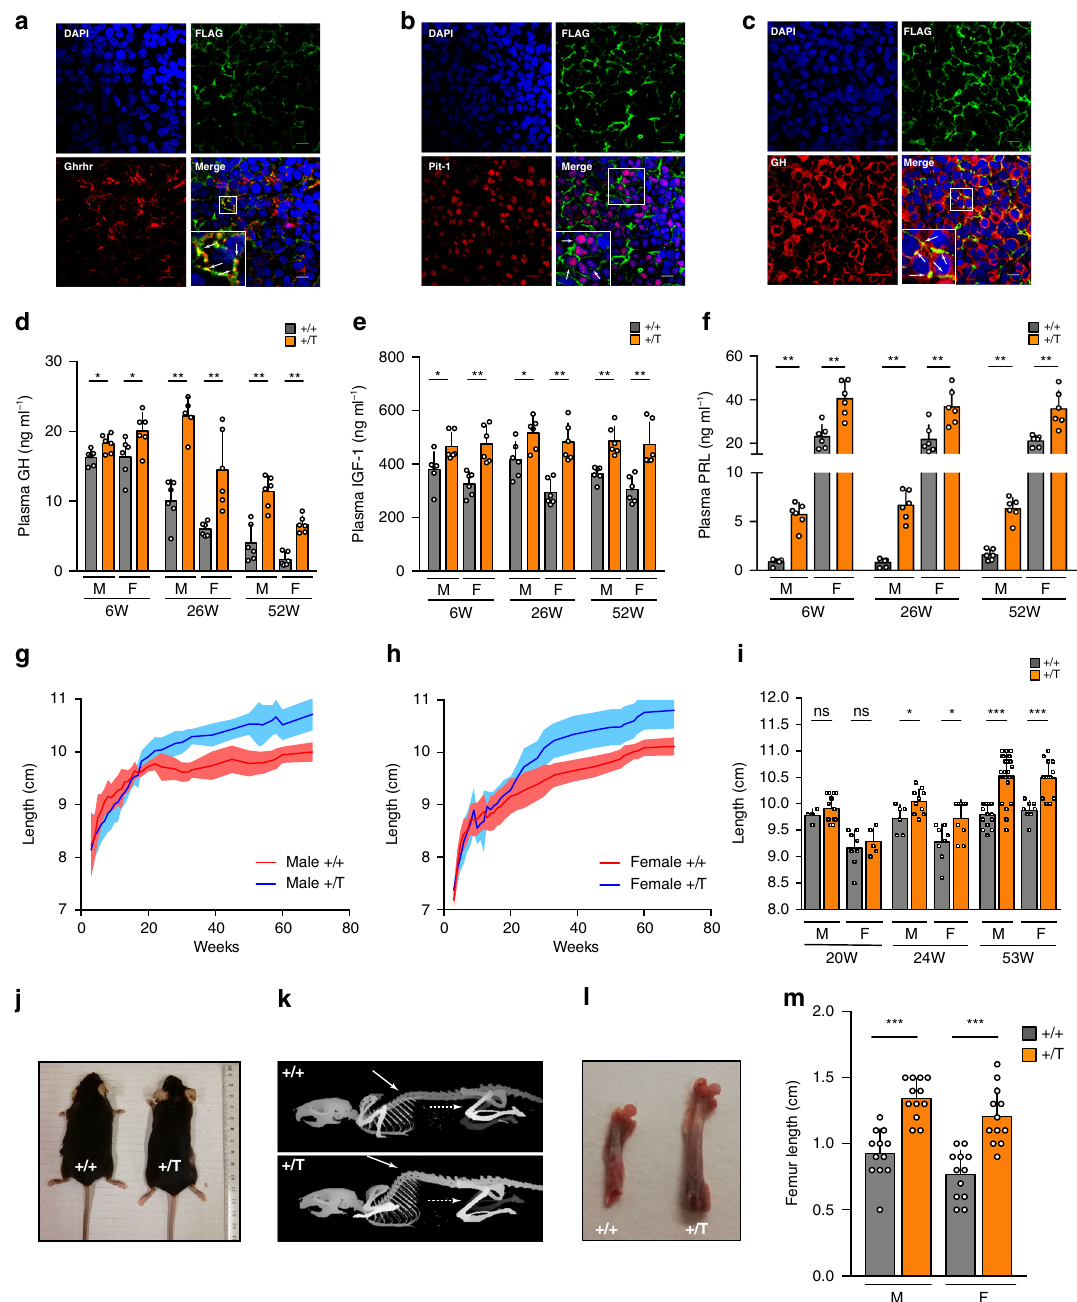
Fig. 1 Gpr101 promotes GH/IGF-1 and PRL hypersecretion and overgrowth in vivo. a – c Immuno fl uorescent staining of anterior pituitary from 29-week- old Ghrhr Gpr101 Tg mice. Blue: DAPI. Green: FLAG antibody. Red: a Ghrhr antibody, b Pit-1 antibody and c . GH antibody. (×60 magni fi cation, scale bar: 10 µ m). These experiments were repeated at least 3 times. d , e Determination in WT ( + / + ) and Ghrhr Gpr101 ( + /T) ( n = 6 mice per group) of plasma levels of d GH. Males 6 W: p = 0.0411, 26 W and 52 W: p = 0.0022. Females 6, 26, and 52 W: p = 0.0022. e IGF-1. Males 6 W and 26 W: p = 0.0260, 52 W: p = 0.0022. Females 6, 26, and 52 W: p = 0.0022. f PRL. Males 6, 26, and 52 W: p = 0.0022. Females 6 W: p = 0.0043, 26 W: p = 0.0087 52 W: p = 0.0022. g , h Growth curves (length, nose-to-anus) of WT ( + / + , males n = 4 – 18 mice, females n = 6 – 16 mice) and Ghrhr Gpr101 ( + /T, males n = 5 – 24 mice, females n = 5 – 13 mice) between week 3 and week 69. i Quanti fi cation and statistical analysis of the lengths of mice at different time points. Males 20 W: n = 4 ( + / + ) and 13 ( + /T) mice, p = 0.4790; 24 W: n = 6 ( + / + ) and 10 ( + /T) mice, p = 0.0493; 53 W: n = 15 ( + / + ) and 24 ( + /T) mice, p = 0.0001. Females 20 W: n = 8 ( + / + ) and 5 ( + /T) mice, p = 0.6169; 24 W: n = 8 ( + / + ) and 9 ( + /T) mice, p = 0.0349; 53 W: n = 8 ( + / + ) and 13 ( + /T) mice, p = 0.0002. j Macroscopic fi ndings regarding body length of WT ( + / + ) and Ghrhr Gpr101 ( + /T) aged 53 weeks. k CT images of WT ( + / + ) and Ghrhr Gpr101 ( + /T) mice (age 27 weeks). Plain arrow indicates skeletal kyphosis and dashed arrow indicates the femur ( n = 4 – 5 mice per group). l . Extracted femurs of 27-weeks-old WT ( + / + ) and Ghrhr Gpr101 ( + /T) mice. m Quanti fi cation of femur length ( n = 12 femurs from 6 mice per group, p = 0.0001 for Males and Females). All Data are Mean ± S.D. For statistical analysis of all data, a two-sided Mann – Whitney test was used. ns not signi fi cantly different; * p < 0.05; ** p < 0.01 *** p <